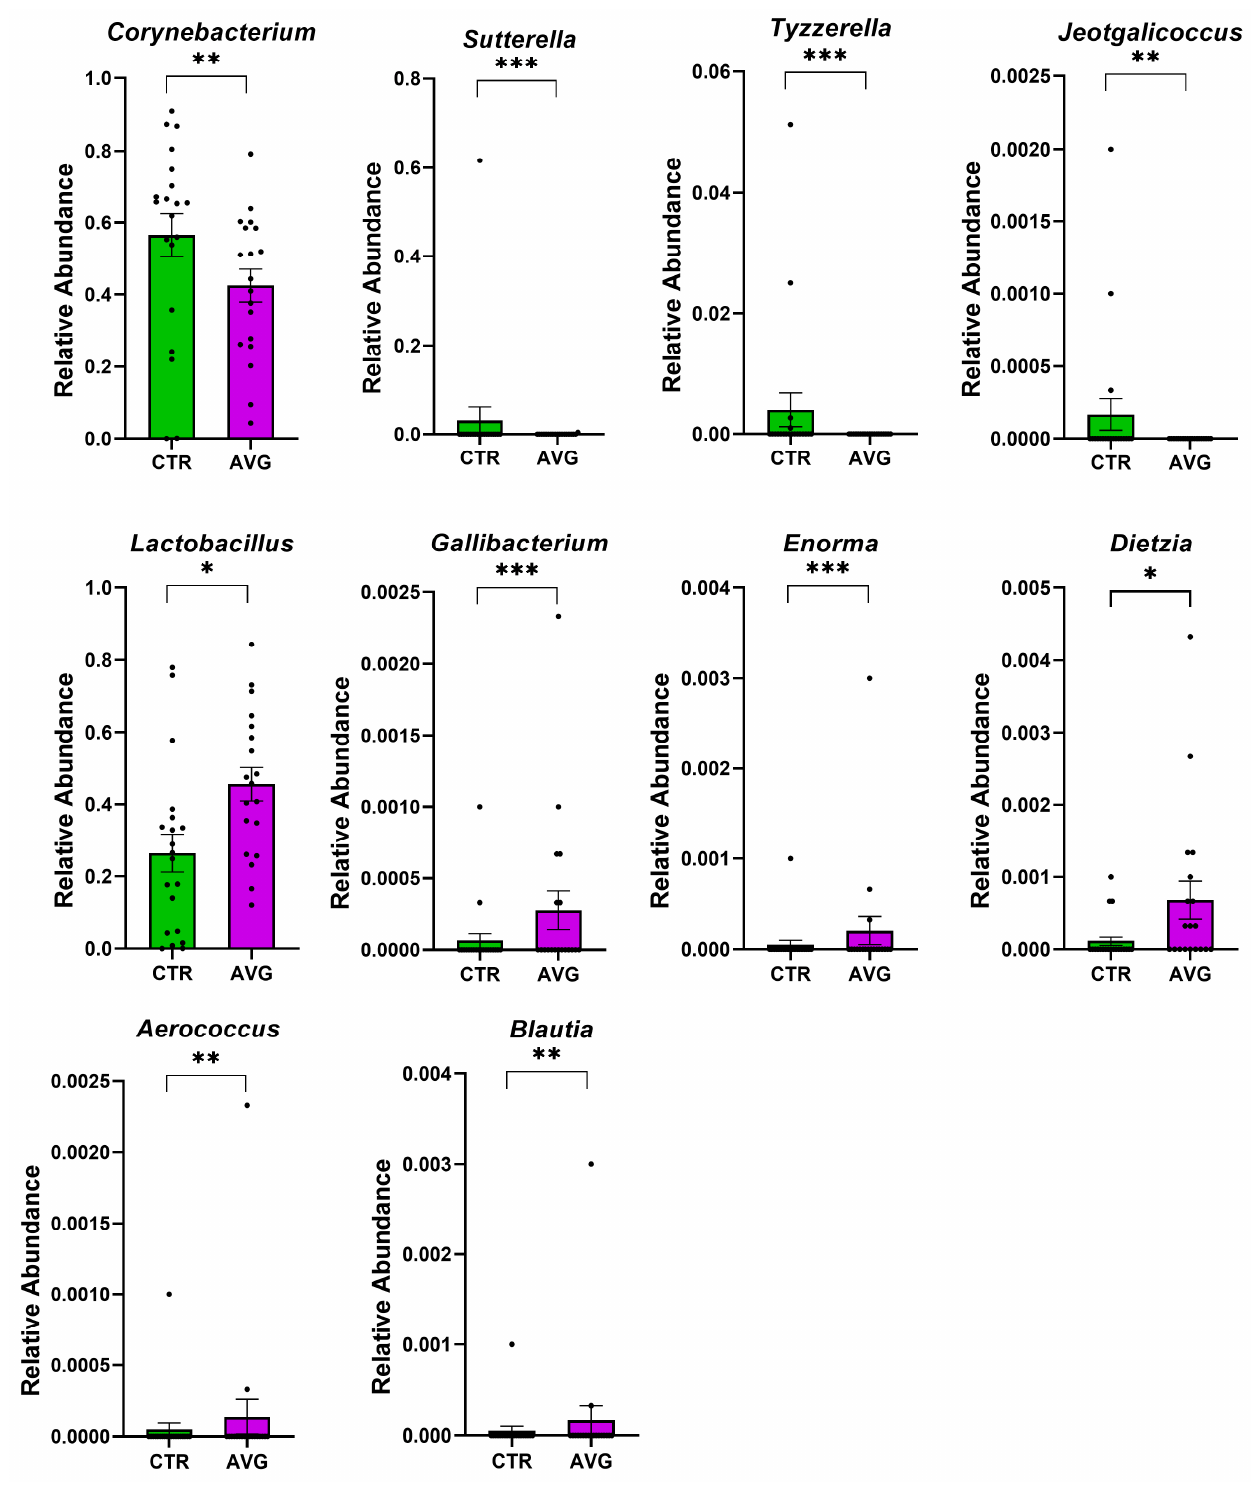
Figure 9. Metastats selected differentially ( p < 0.001) abundant genera in the jejunal mucosa. The asterisk indicates significance level (*** p < 0.001; ** p < 0.01; * p < 0.05). Each dot represents one sequenced sample relative abundance.